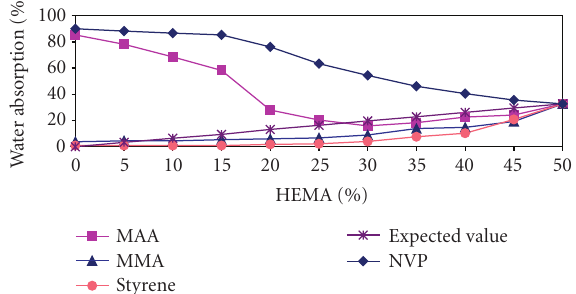
Figure 7: Water absorption of pHEMA with di ff erent copolymers.